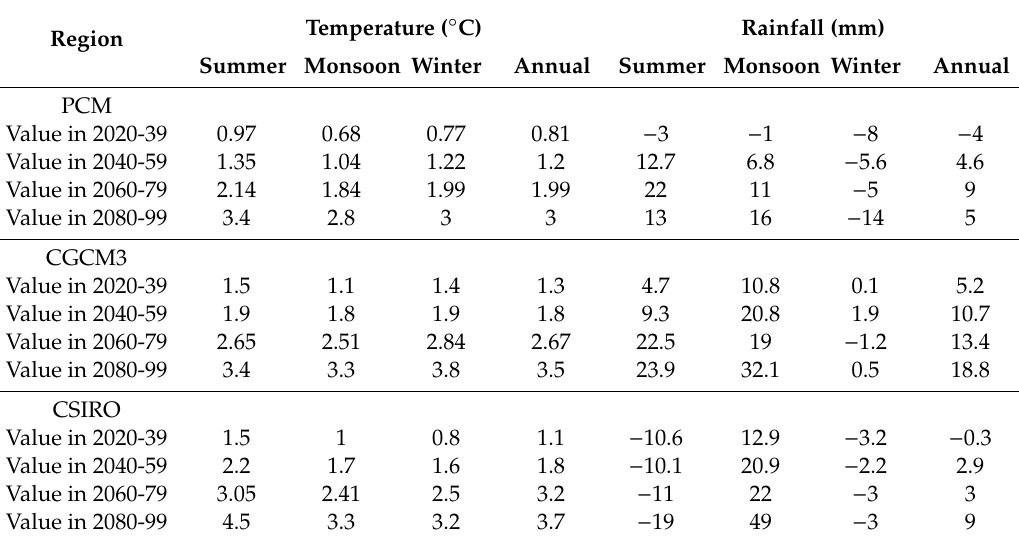
Table 3. Projected changes in temperature and rainfall by three climate models.